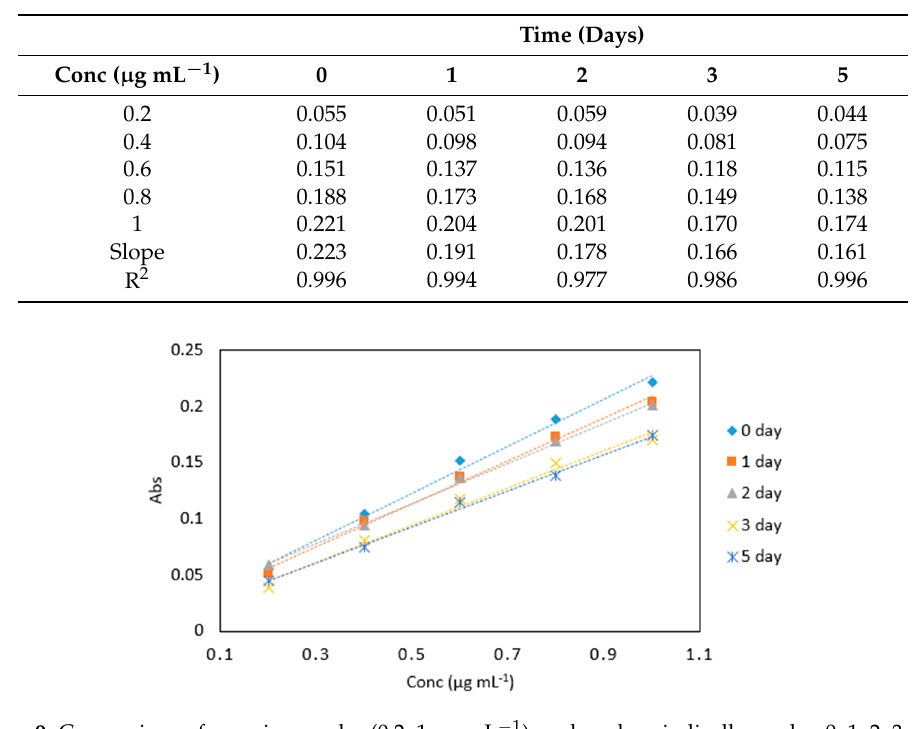
Figure 9. Comparison of arsenic samples (0.2–1 µ g mL − 1 ) analyzed periodically on day 0, 1, 2, 3 and 5 under the same conditions with the leucomalachite green dye and in sodium triacetate buffer (pH 5.5). All measurements were carried out in triplicate ( n = 75).